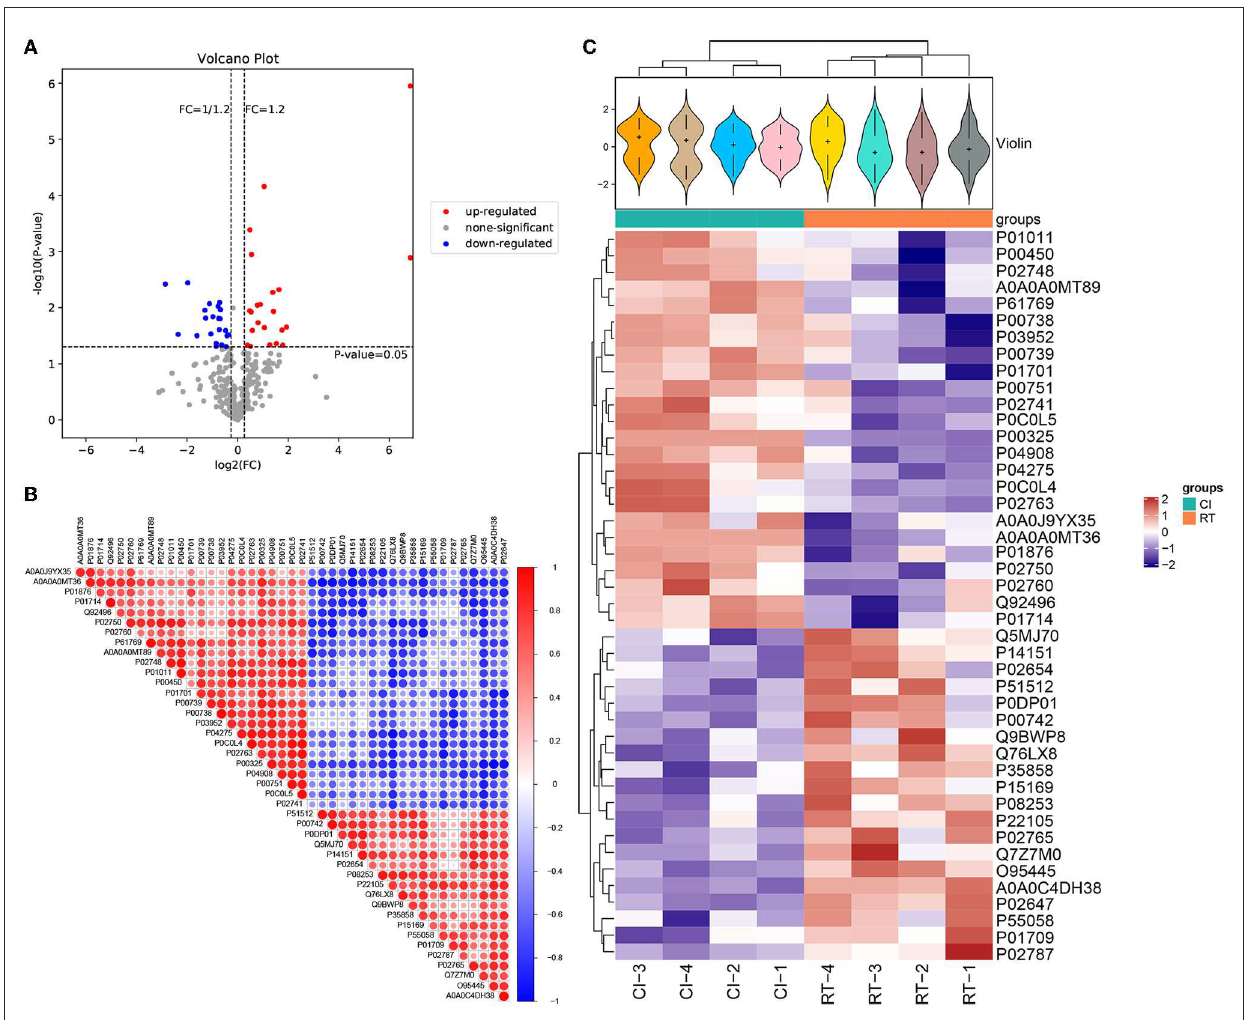
FIGURE3 (A) Volcano plot of differentially expressed proteins. The horizontal coordinate of the volcano plot is log2 (FC), and its value is farther from the 0 point indicating a larger difference, with upward adjustment on the right and downward adjustment on the left. The vertical coordinate is –log10 ( P -value), and the farther the value is from the 0 point, the larger the difference is. The blue points in the graph indicate down-regulated differentially expressed proteins, the red points are up-regulated differentially expressed proteins, and the gray points are non-significant differentially expressed proteins. (B) Correlation analysis of differentially expressed proteins. In the figure, red is positive correlation, blue is negative correlation, the size of the circle represents the level of significance of the correlation test, and the color shade represents the magnitude of the correlation coefficient. (C) Cluster analysis heat map of differentially expressed proteins. The upper part is a violin plot, the violin plot is a combination of box line plot and density plot, the flatter the box the more concentrated the data are, the outline of the box reflects the probability distribution of expression values, different color fills represent different samples, the “ + ” in the middle of the violin indicates the median of the data, the vertical axis is protein expression; the column annotations of the heat map are below the violin, the same. The samples in the same subgroup correspond to the same color block annotation; the clustering heat map below, clustering according to protein expression, red indicates high expression protein, blue indicates low expression protein, each row indicates the expression of each protein in different